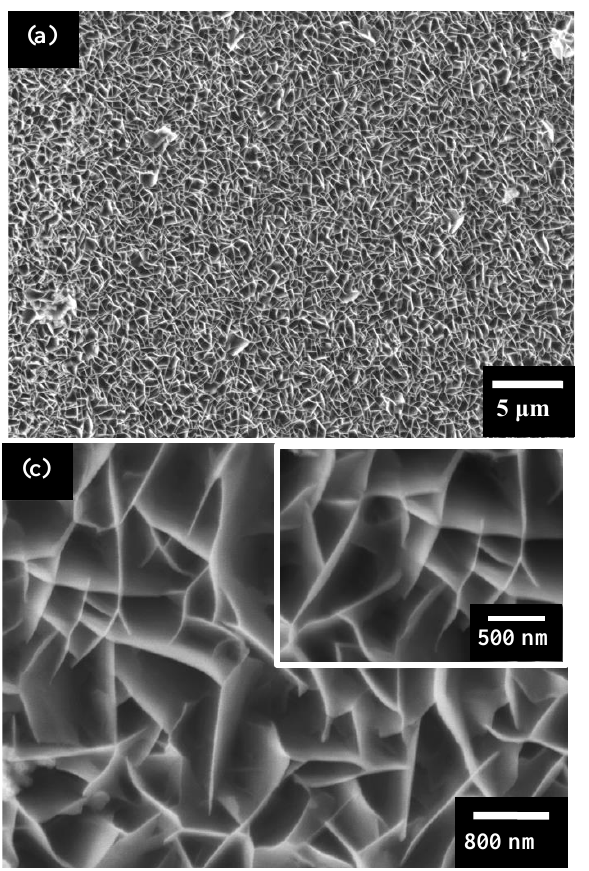
Figure 1. Current versus time curve during the electrochemical deposition of Li-Al-CO 3 LDH thin film in the Li + /Al 3+ aqueous solution at a constant potential. A DC voltage of 5 V was applied in the electrochemical cell for 2 h at room temperature.